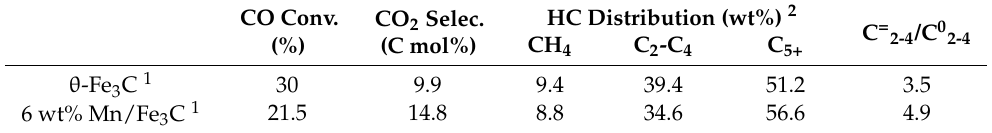
Figure 5. FTS performances of catalysts. ( a ) CO conversion and product selectivity of the θ -Fe 3 C sample with the time on stream. ( b ) Distributions of hydrocarbons over θ -Fe 3 C and 6 wt% Mn/Fe 3 C Table 4. Performance of catalysts in FTS.